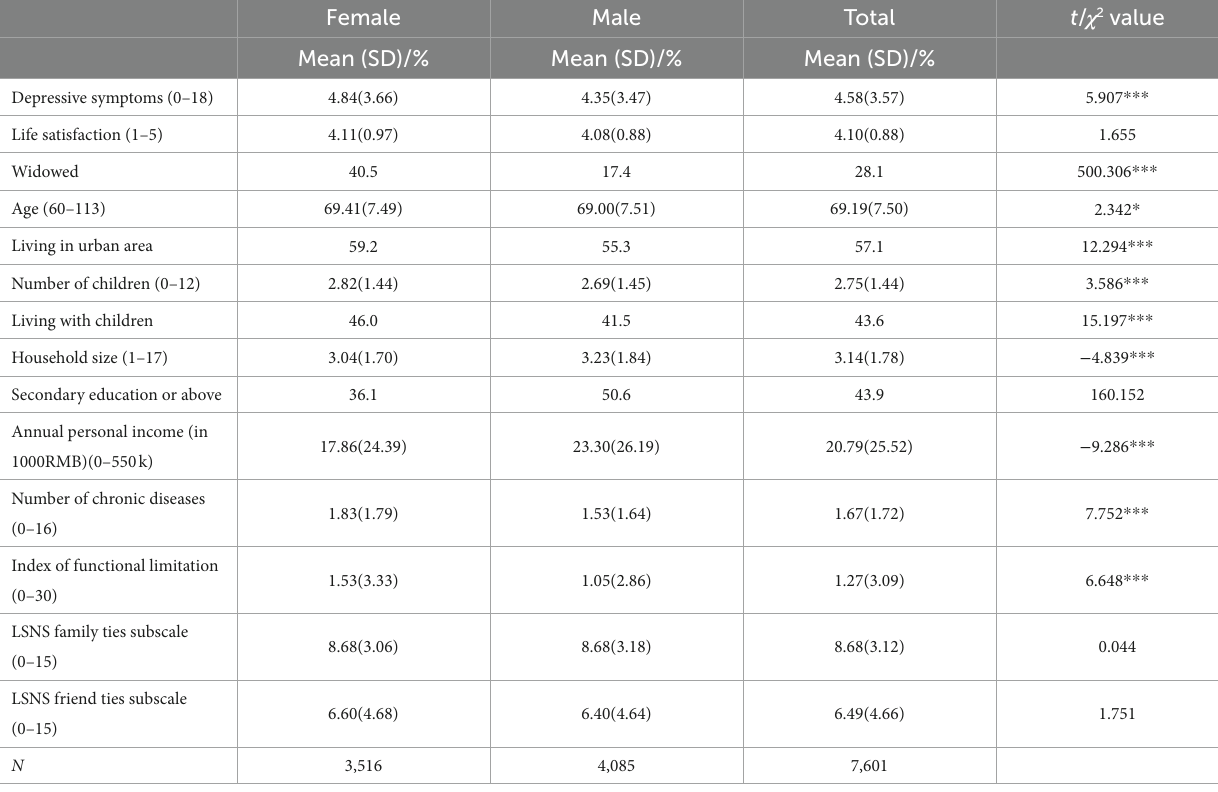
TABLE 1 Descriptive statistics of male and female older